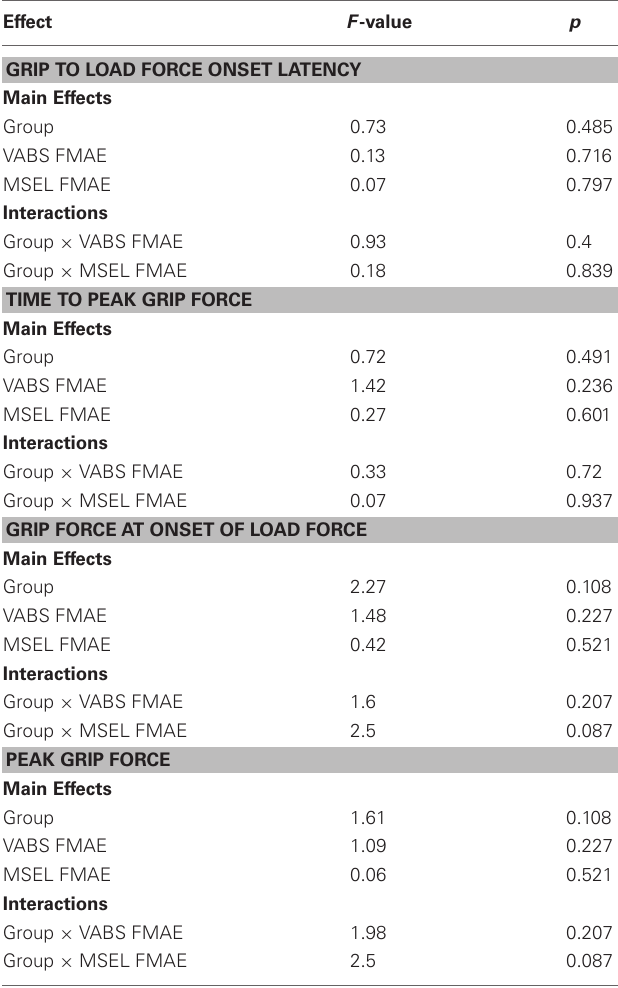
Table 11 | Effect of fine motor age equivalents (FMAE) on motor coordination